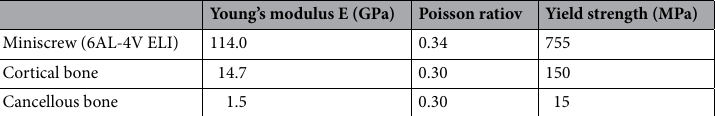
Table 1. Mechanical properties of three different modeled